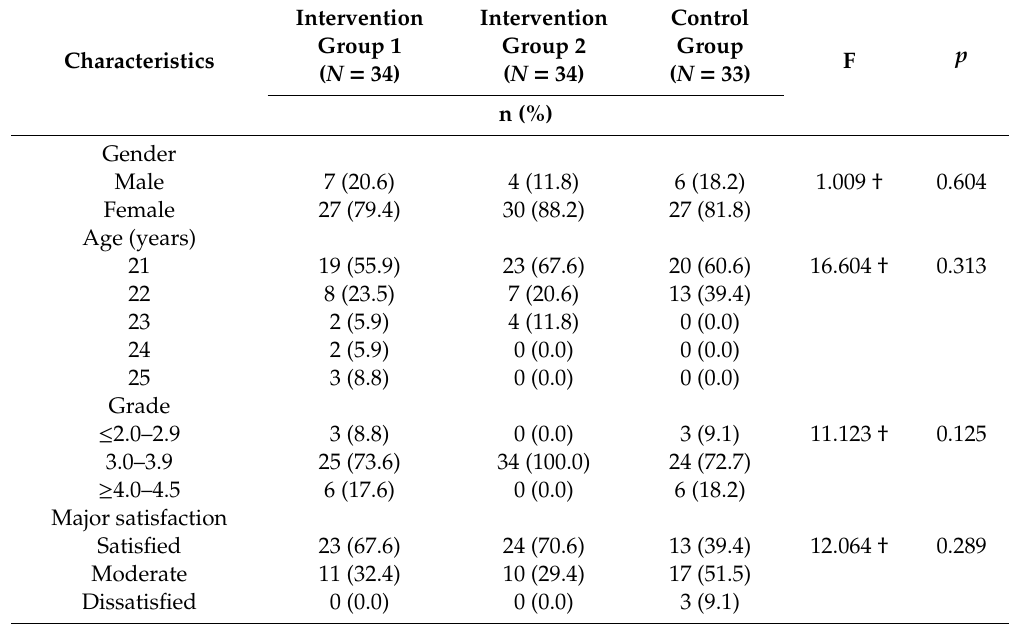
Table 1. General characteristics of the study participants and homogeneity.